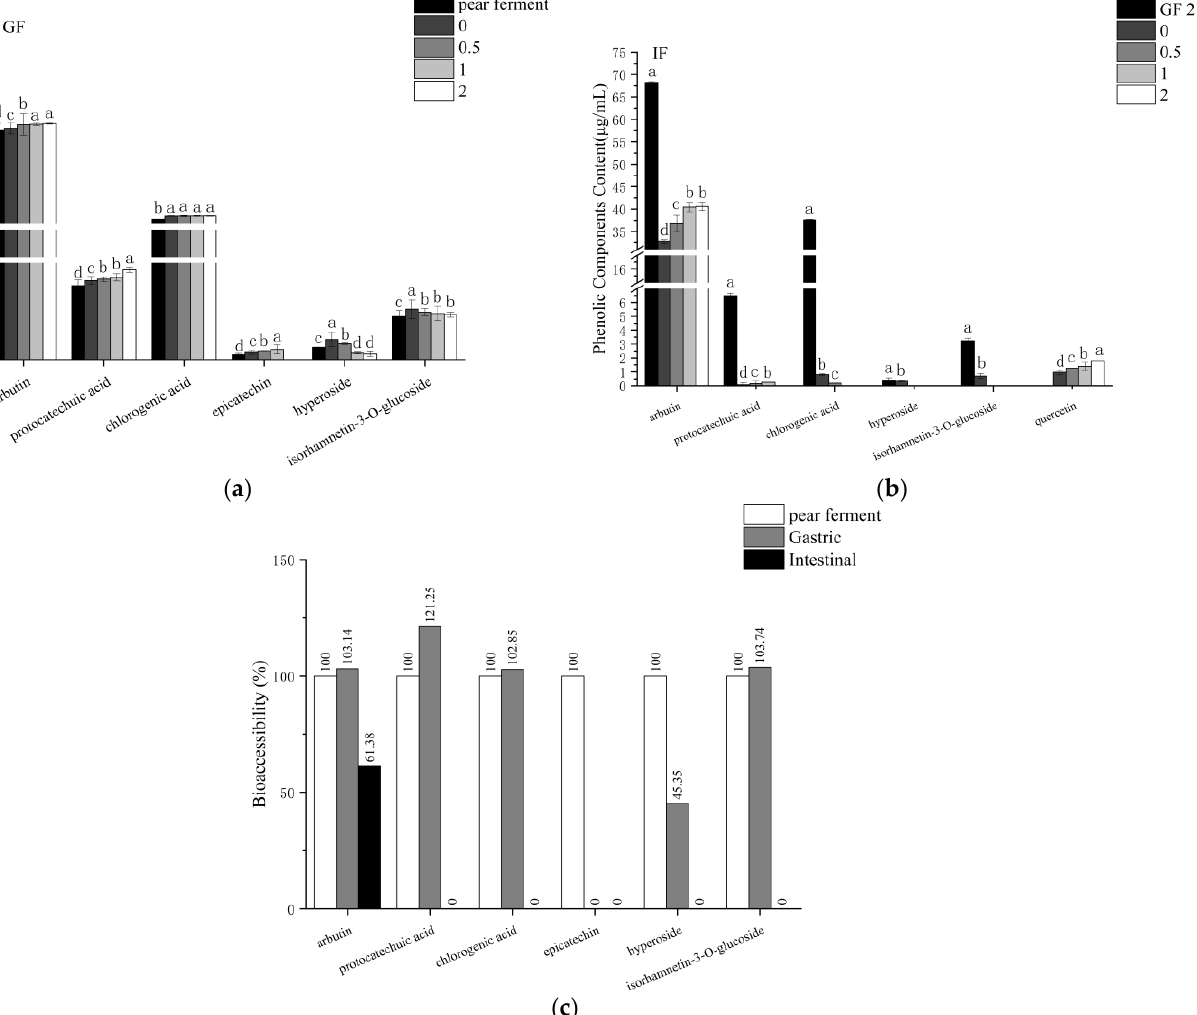
Figure 9. Changes of phenolic components of ‘ Xuehua ’ pear ferment during the simulated digestion in vitro. ( a ) indicates simulated gastric digestion; ( b ) indicates simulated intestinal digestion; ( c ) indicates bio-accessibility subjected to simulated in vitro digestion. Different letters indicate significant differences in the same group under different digestion times ( p < 0.05). Data shown as means ± SD of three replicates ( n = 3).